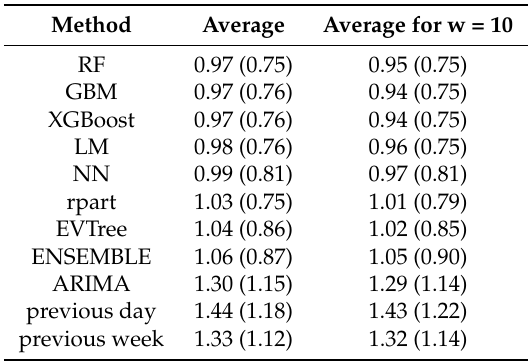
Table 4. Average MAE obtained by the methods for all the values of historical window and on all the buildings. The standard deviation is shown in